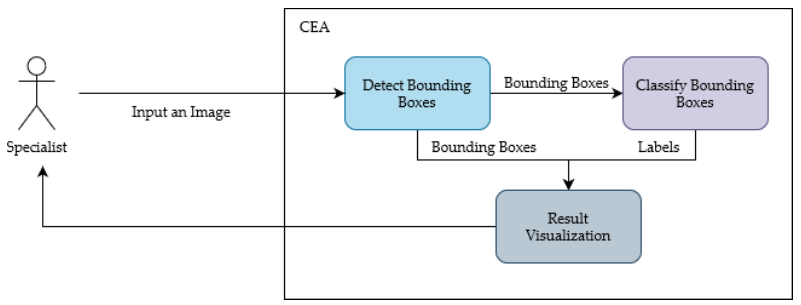
Figure 4. CEA interaction flow.